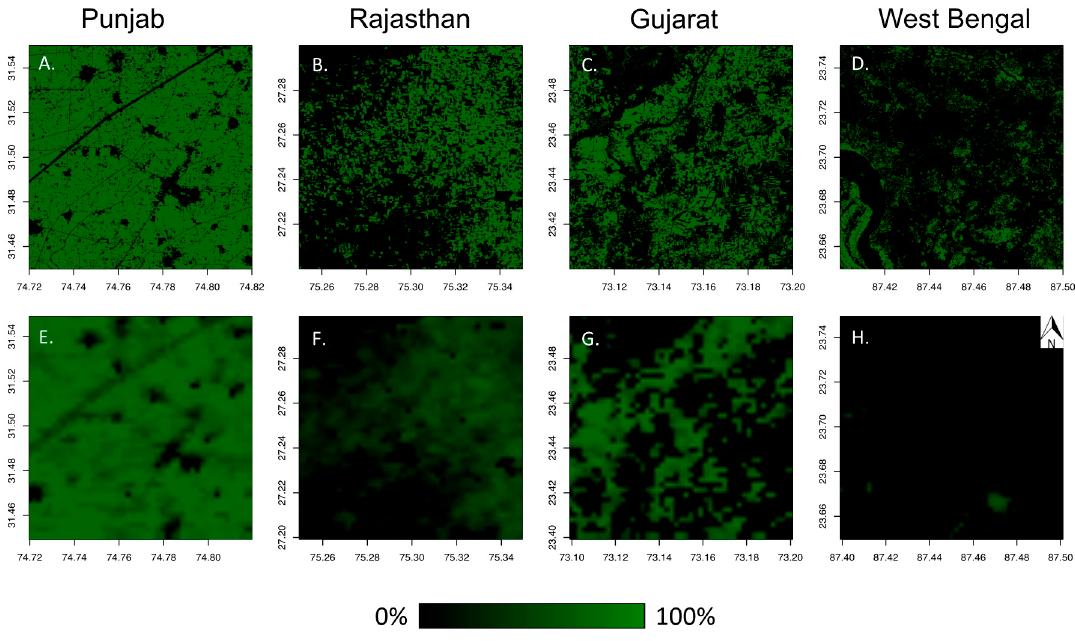
Figure 3. Cropped area as shown using high-resolution imagery ( A – D ) and cropped area estimates produced using the MSA ( E – H ) for Punjab ( A , E ), Rajasthan ( B , F ), Gujarat ( C , G ), and West Bengal ( D , H ). We selected these four sites to represent the range of validation accuracies from high (Punjab and Rajasthan), moderate (Gujarat), to low (West Bengal) R 2 values. We find that overall cropped area patterns produced using the MSA match those seen in the high-resolution imagery, except for in the case of West Bengal. This lack of agreement is likely because the crops seen in the high-resolution imagery ( D ) were planted during the monsoon season, which occurs before the growing season window used by the MSA ( H